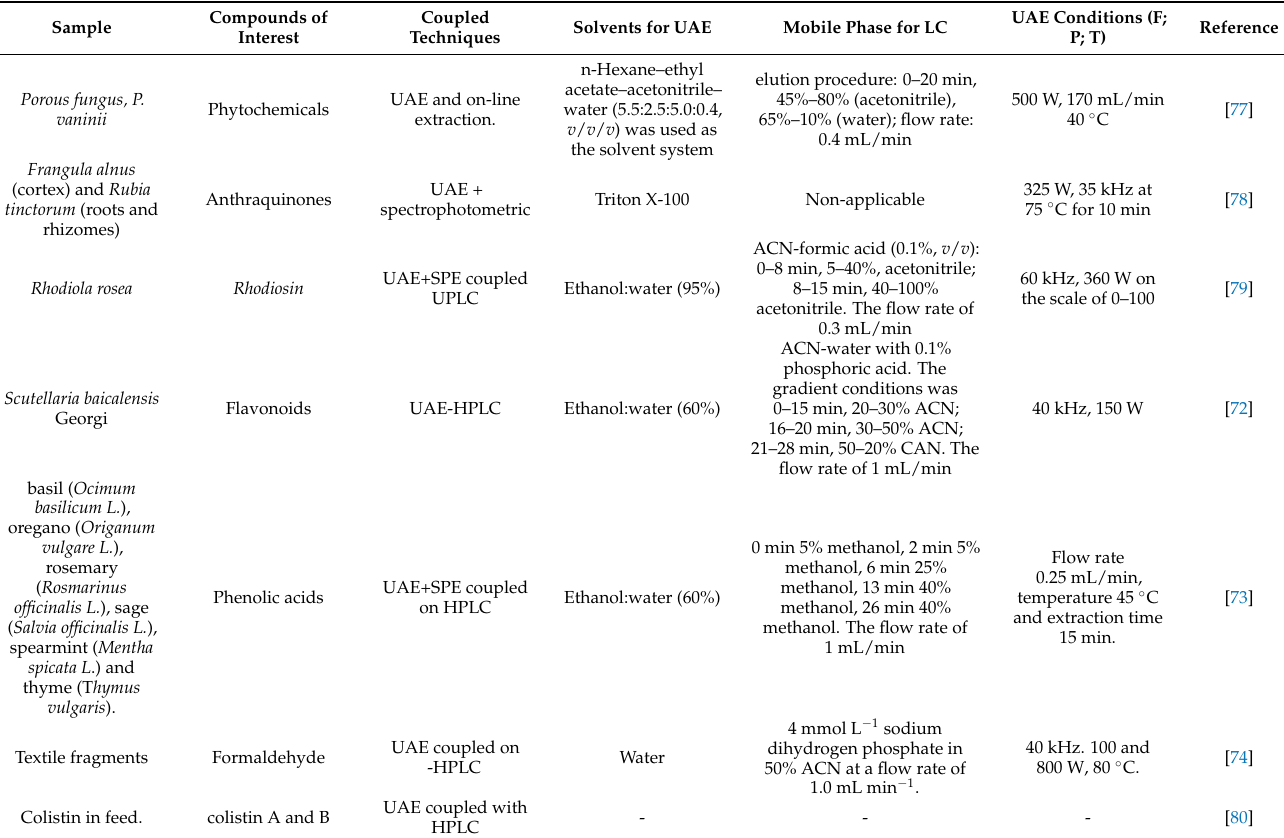
Table 5. Comprehensive report of UAE systems coupled with on-line analysis systems for solid matrices from vegetable